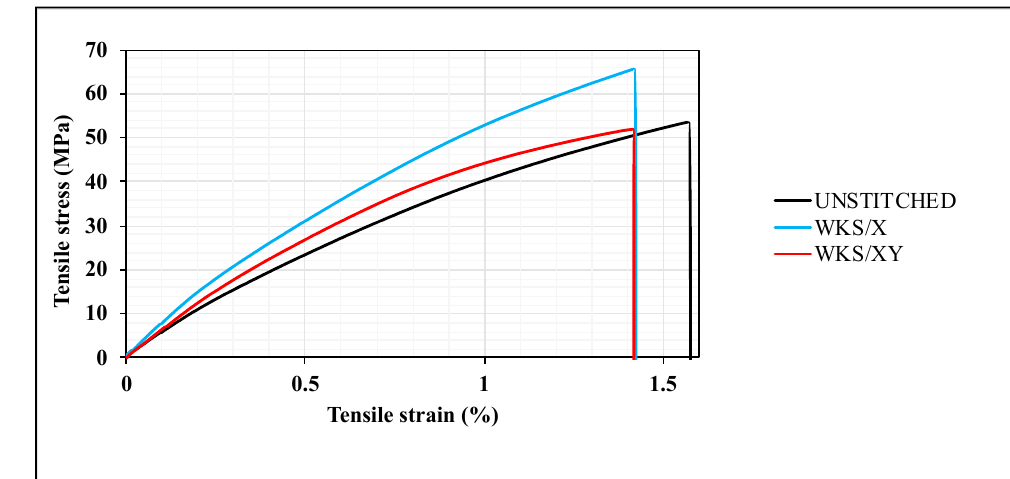
Figure 10. Tensile stress versus tensile strain average curves of the unstitched and silk-fiber-stitched woven kenaf composites.